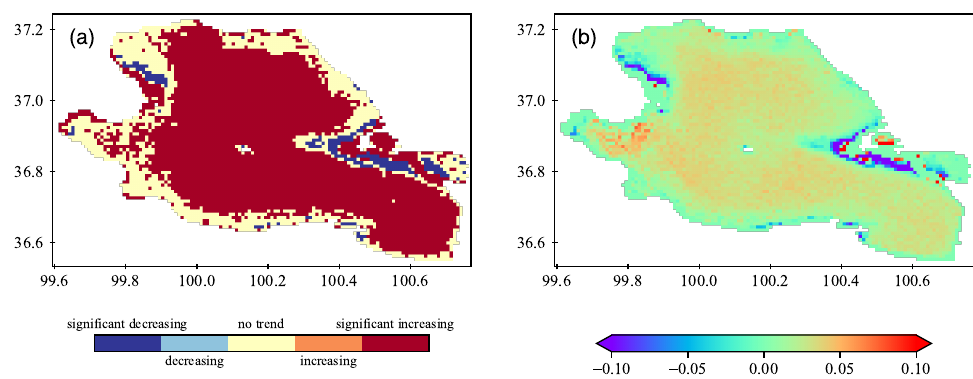
Figure 11. Annual variation trend of C SPM in Qinghai Lake from 2001 to 2020 using the M–K test (( a ) is the variation trend and ( b ) is the Theil-Sen’s